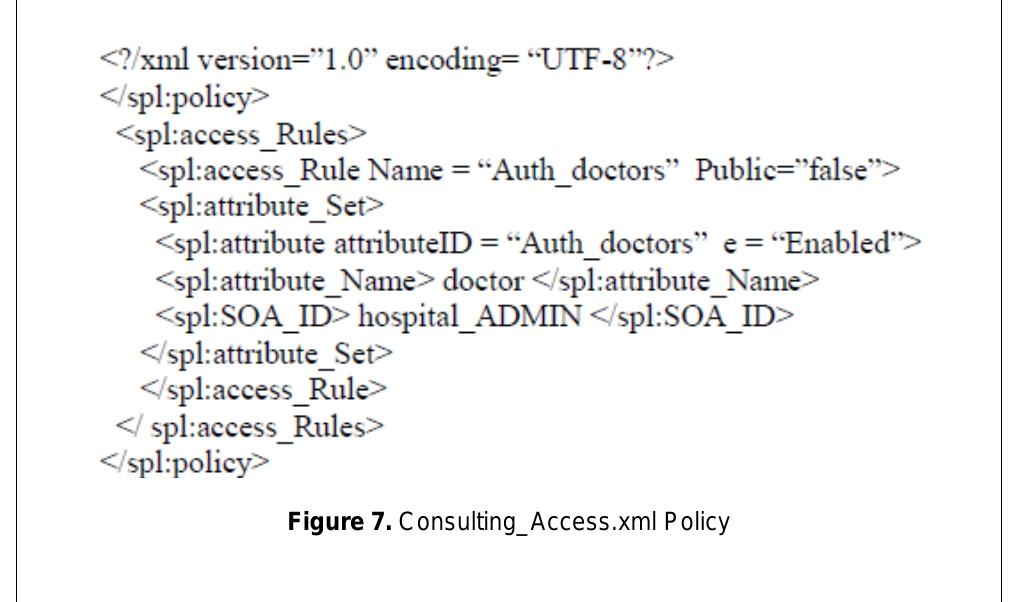
Figure 7. Consulting_Access.xml